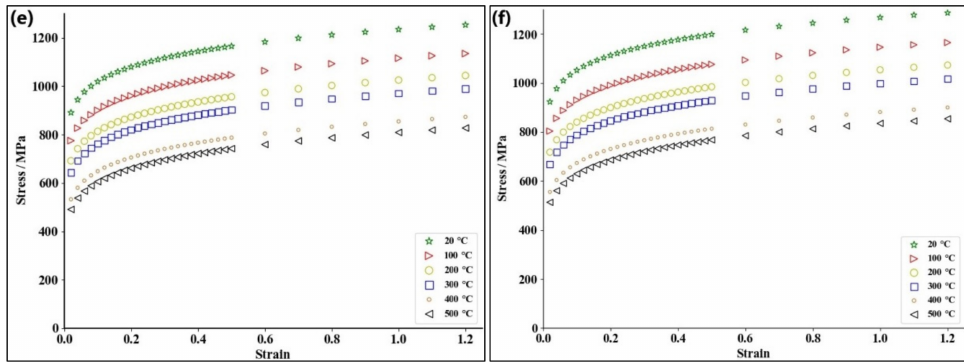
Figure 5. The stress–strain curve of AlFeSi phase under different strain rates: ( a ) strain rate 0.001 s –1 ; ( b ) strain rate 0.01 s –1 ; ( c ) strain rate 0.1 s –1 ; ( d ) strain rate 10 s –1 ; ( e ) strain rate 100 s –1 ; ( f ) strain rate 1000 s –1